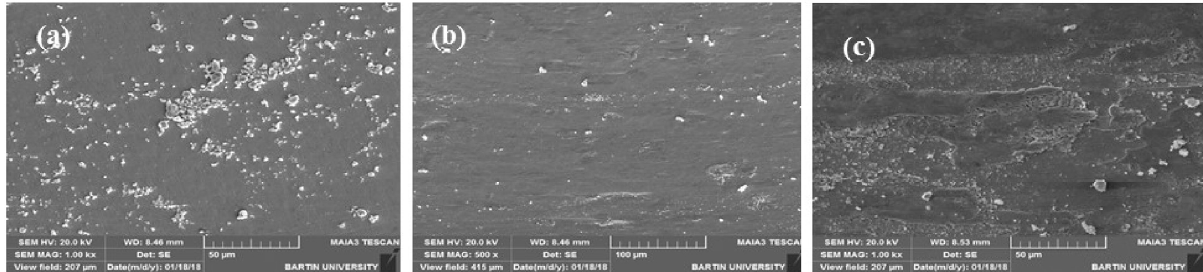
Fig. 9 SEM morphologies of the wear surface of the CoCrFeNiTi 0.5 Al 0.5 alloy at (a) room temperature, (b) 250 ° C, and (c) 500 °